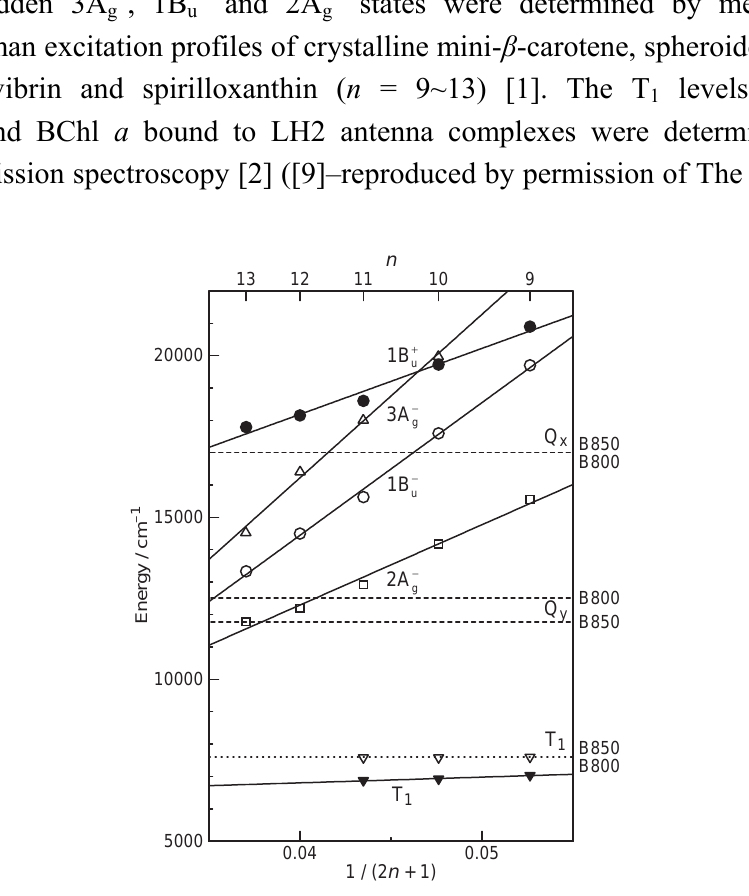
and Chl c having the porphyrin skeleton. 1 2